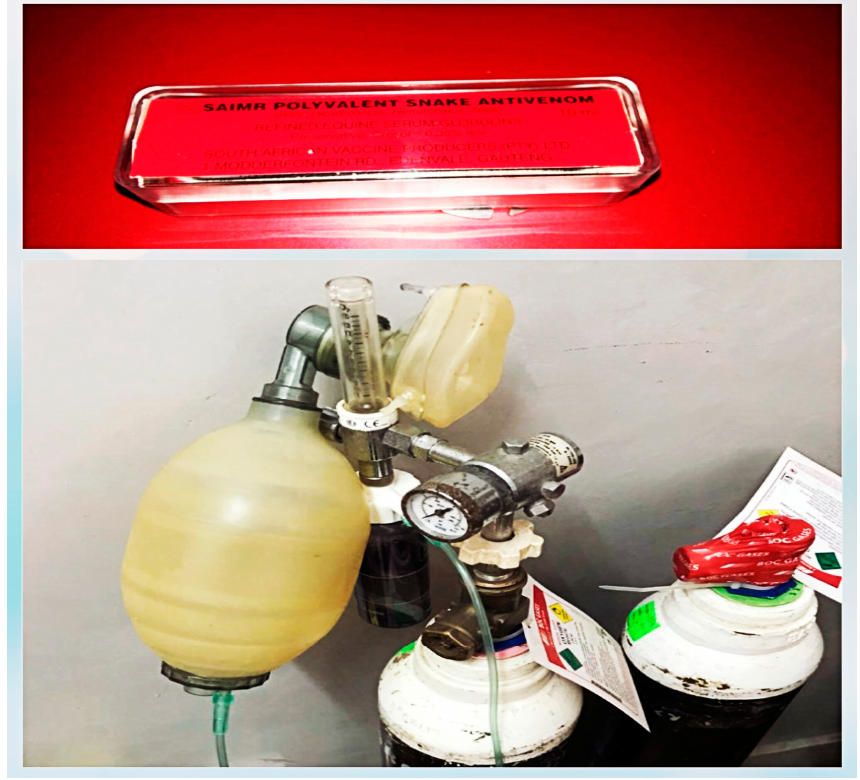
Figure 3. Antivenom used on the victim and the positive pressure oxygen delivery system used in the resuscitation. Trop. Med. Infect. Dis. 2018 , 3 , x FOR PEER REVIEW